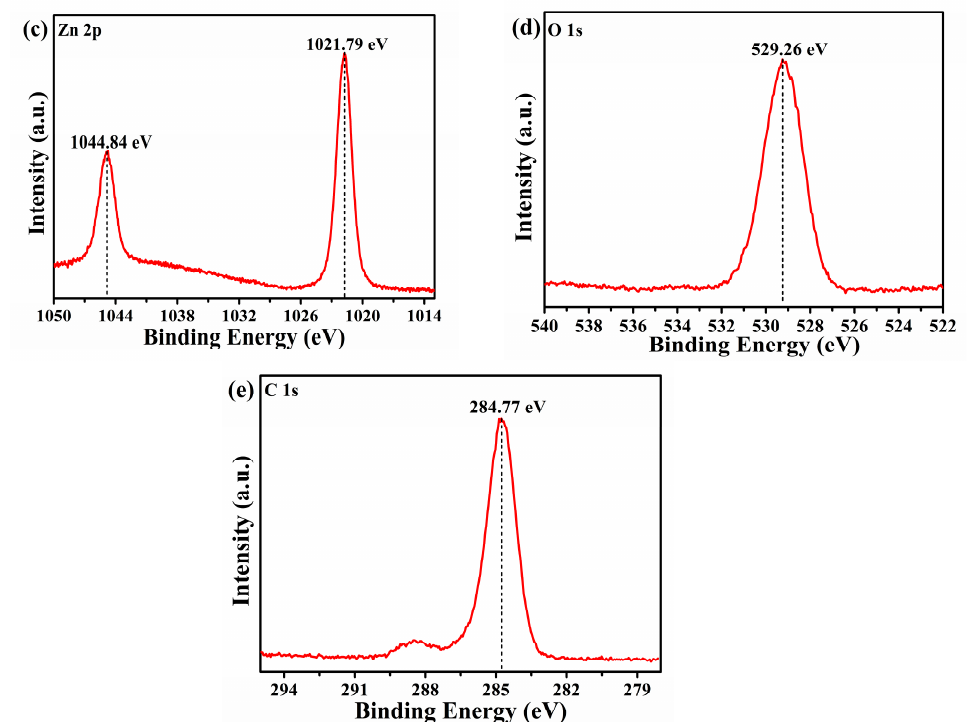
Figure 2. XPS of Zn 1-x Ni x O nanorod arrays: ( a ) Survey spectra, ( b ) Ni 2p, ( c ) Zn 2p, ( d ) O 1s, and ( e ) C 1s core-level spectra.